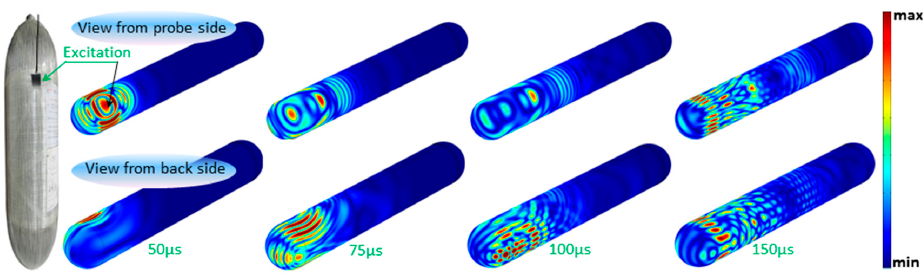
Figure 13. Wave field evolution in a vessel at different propagation time-steps